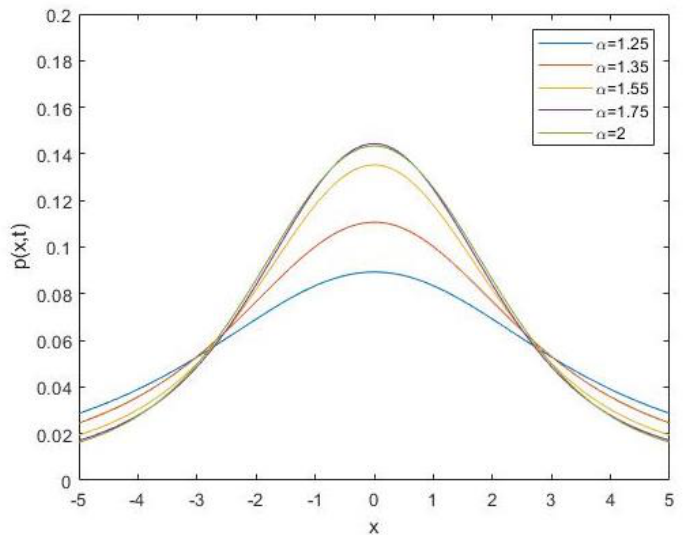
Figure 2. Analytical solution of ( FFPE ) of Equation (30) at different values of α = 1.15,1.35,1.55,1.75, and 2 around x = 0, in the symmetric case with γ =